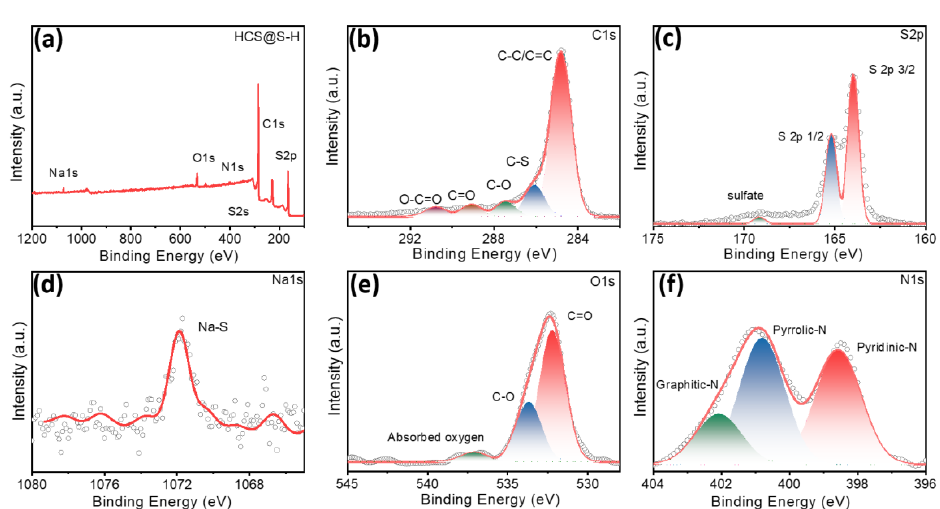
Figure 1. The physical-chemical properties of the as-resulted samples: XRD ( a ), specific surface area ( b ), Raman ( c ), porous distribution ( d ), TG curves ( e ), particles size distribution ( f ), FTIR ( g ) and the formation mechanism ( h ).